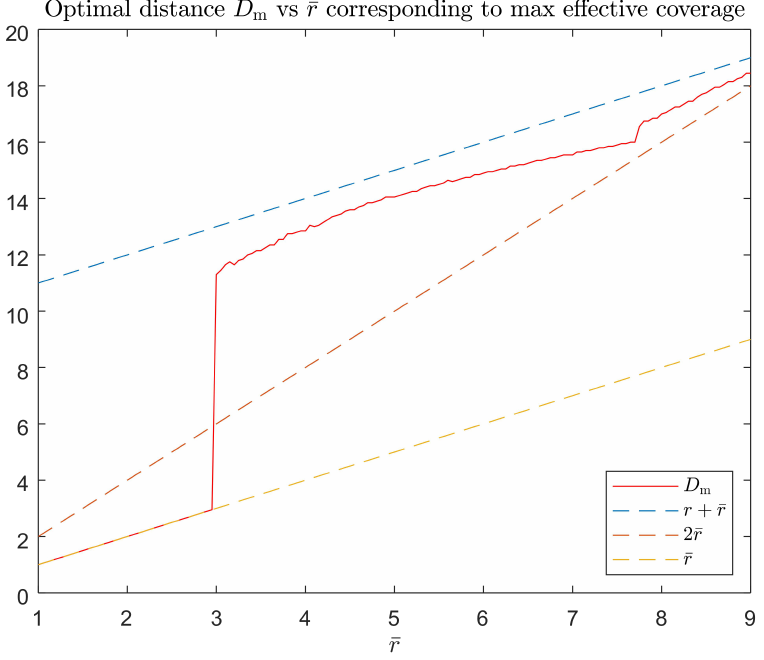
Figure 5. Relation between the optimal D and ¯ r corresponding to the maximum team’s effective